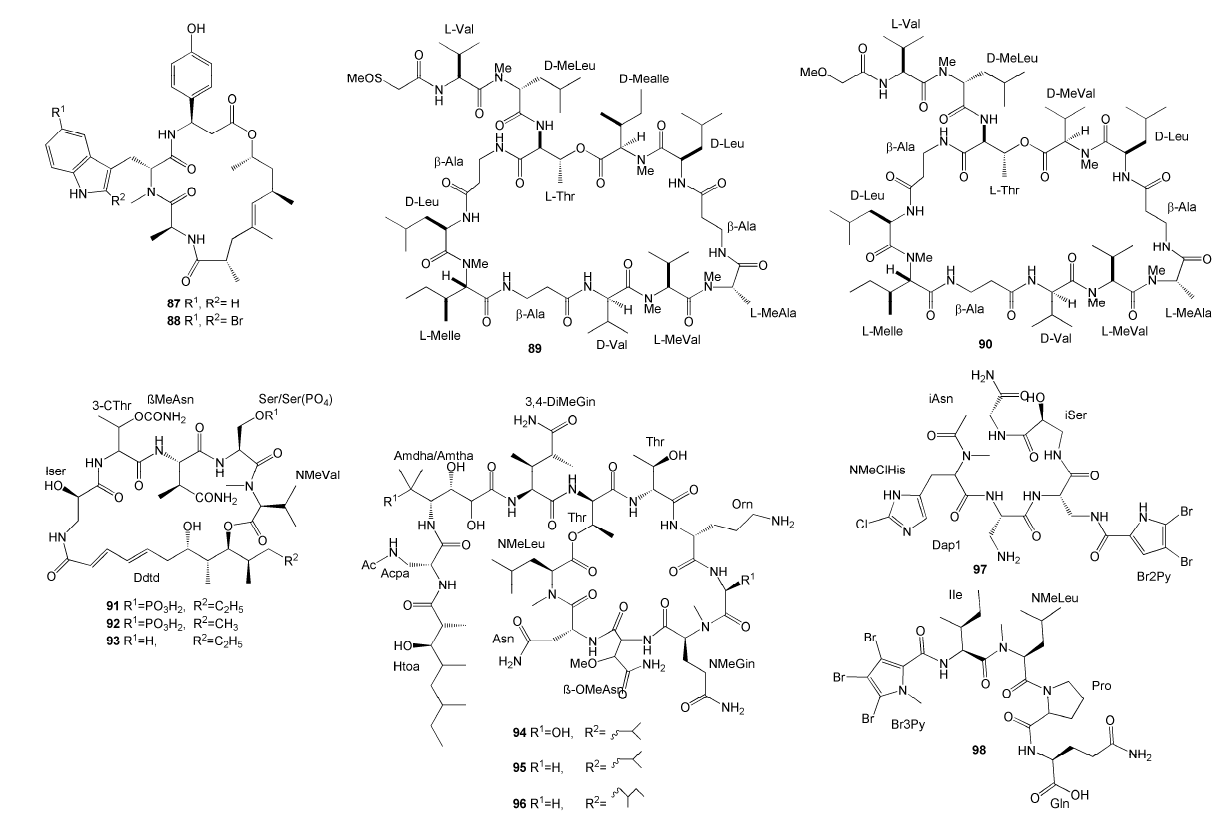
Figure 7. Chemical structures of 87-98.